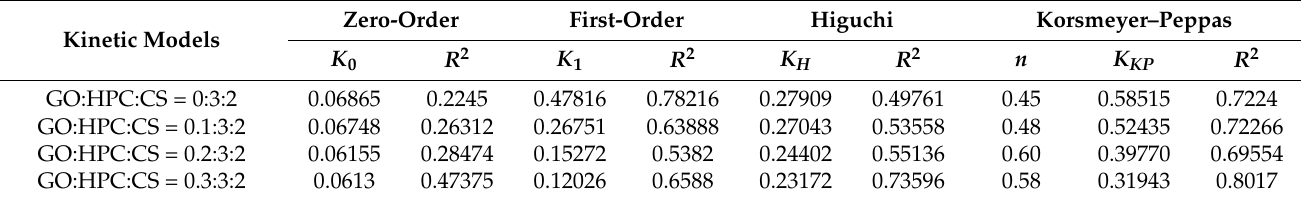
Table 2. Kinetic parameters of four models for 5-Fu release at pH =